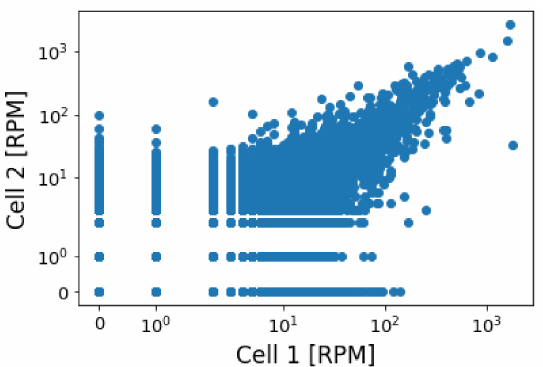
Figure 4. Data validation. A scatter plot of two isogenic cells from a single-cell study of a breast cancer tumor model [4]. The cells were arbitrarily chosen given the open-access expression matrix. The expression values for the transcripts are in reads per million (RPM).